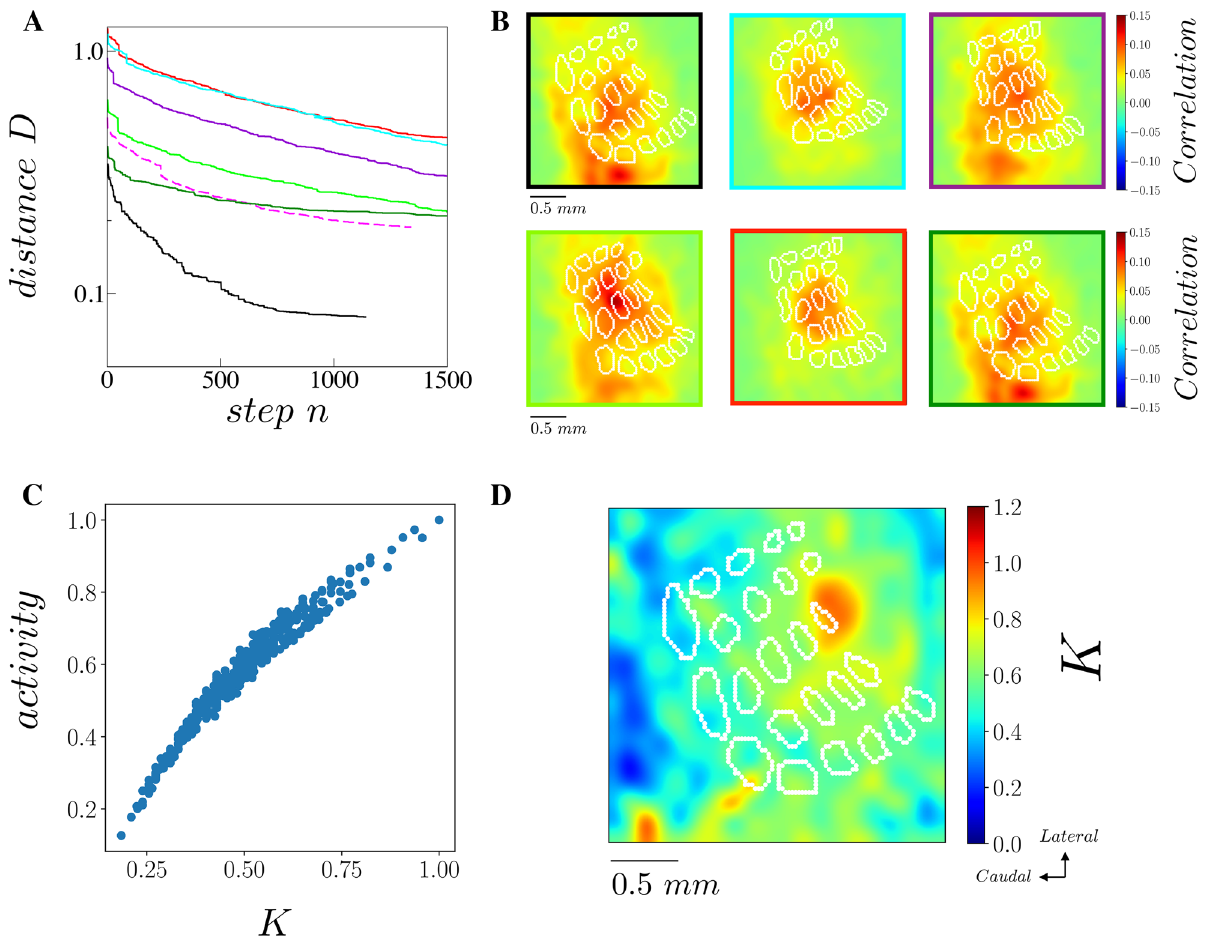
Figure 9. Inversion procedure. (A) Distance D (from Eq. 19 in function of the step number n of the inversion procedure. Solid lines show the convergence for the 6 different mice (black line is from the mouse illustrated in Figs. 1,4,7A) and the dashed line is obtained from the inversion procedure applied to VSDi obtained by stimulating C4 (same mouse as black line). ( B) Correlation (averaged over 20 ms) between reconstructed and experimental VSDi for the 6 mice. The color of the frame is indicative of the identity of the mouse as in panel (A) . ( C) Each dot shows the maximum activity (in time) and the value of K at each pixel (Pearson correlation coefficient p c = 0.95). ( D) The reconstructed spatial distribution of K from the inversion procedure applied to recorded VSDi signals in response to C4 whisker